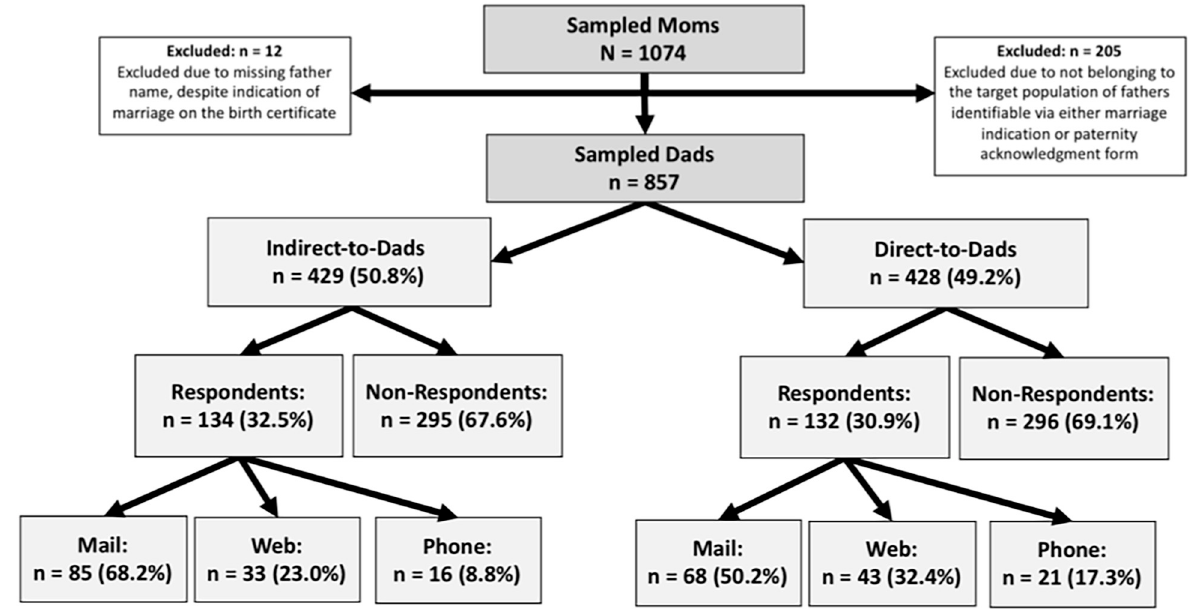
Fig 1. Flow chart of the selection of eligible participants sampled the Pregnancy Risk Assessment Monitoring System for Dads Pilot Study by study arm, survey response, and mode of survey completion. NOTE: All percentages are weighted. Father analysis weight is his sampling weight. Numbers may not sum to 100% due to